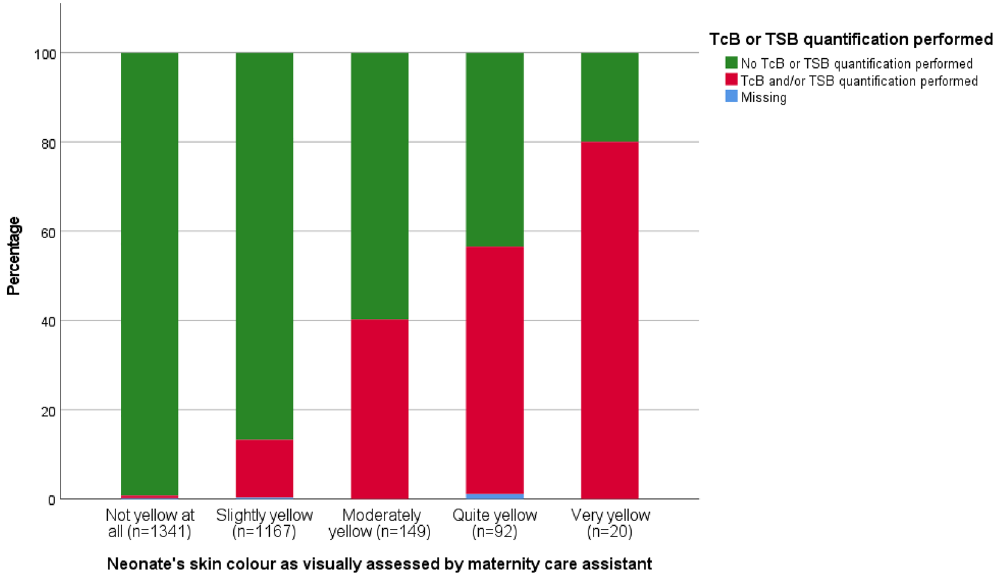
Figure 2. Proportion of assessment resulting in TcB or TSB being quantified according to degree of visible jaundice. TcB transcutaneous bilirubin, TSB total serum bilirubin.